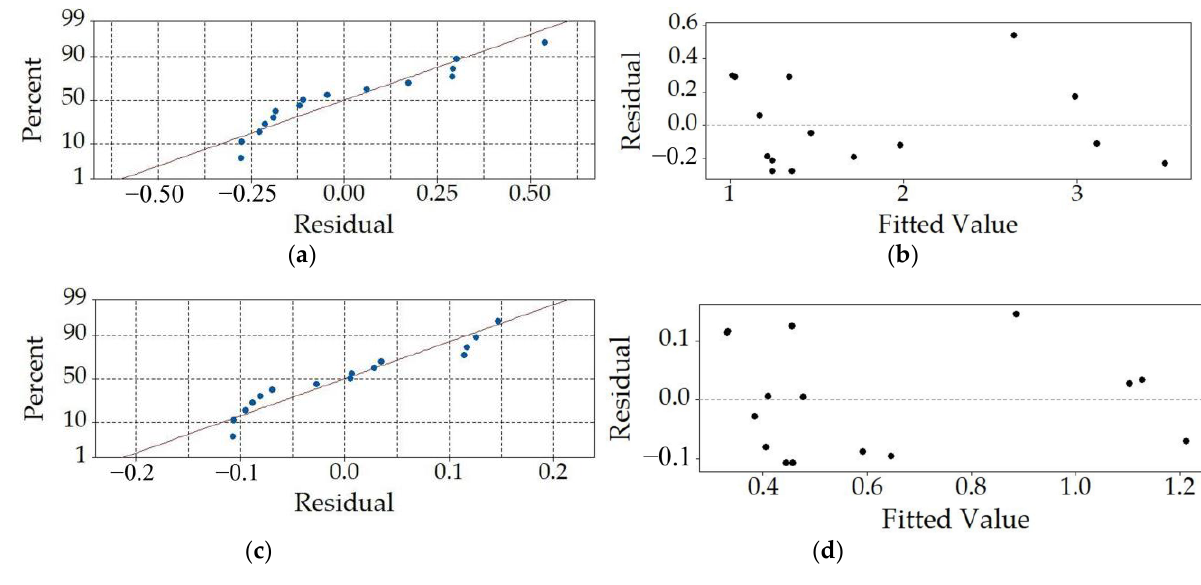
Figure 9. Residual analyses for P 5p-p and P ave_0.04s : normal probability plots ( a , c ) and residuals vs. the fitted value plots ( b , d ).